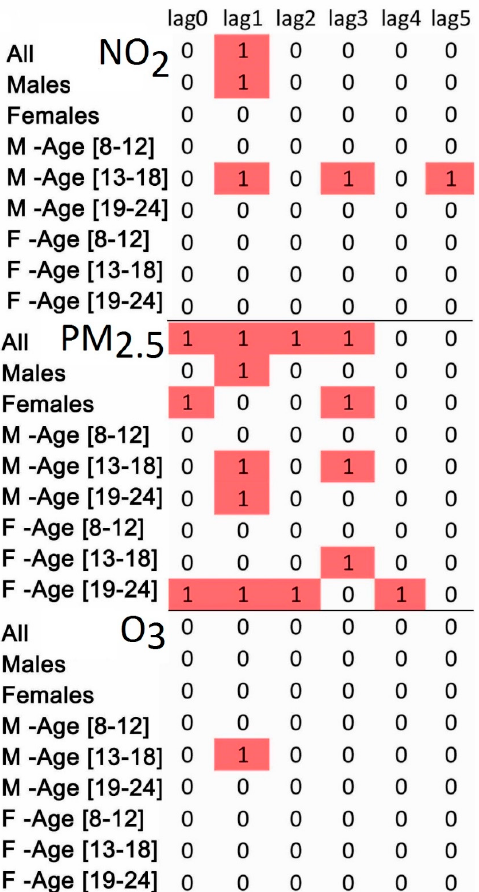
Figure 1. Qualitative representation of the associations by sex and age group for three air pollutants: red (1)—positive statistically significant, white (0)—neutral. F—female, M—male. Lags are in days. Toronto, Canada, 2004–2015.